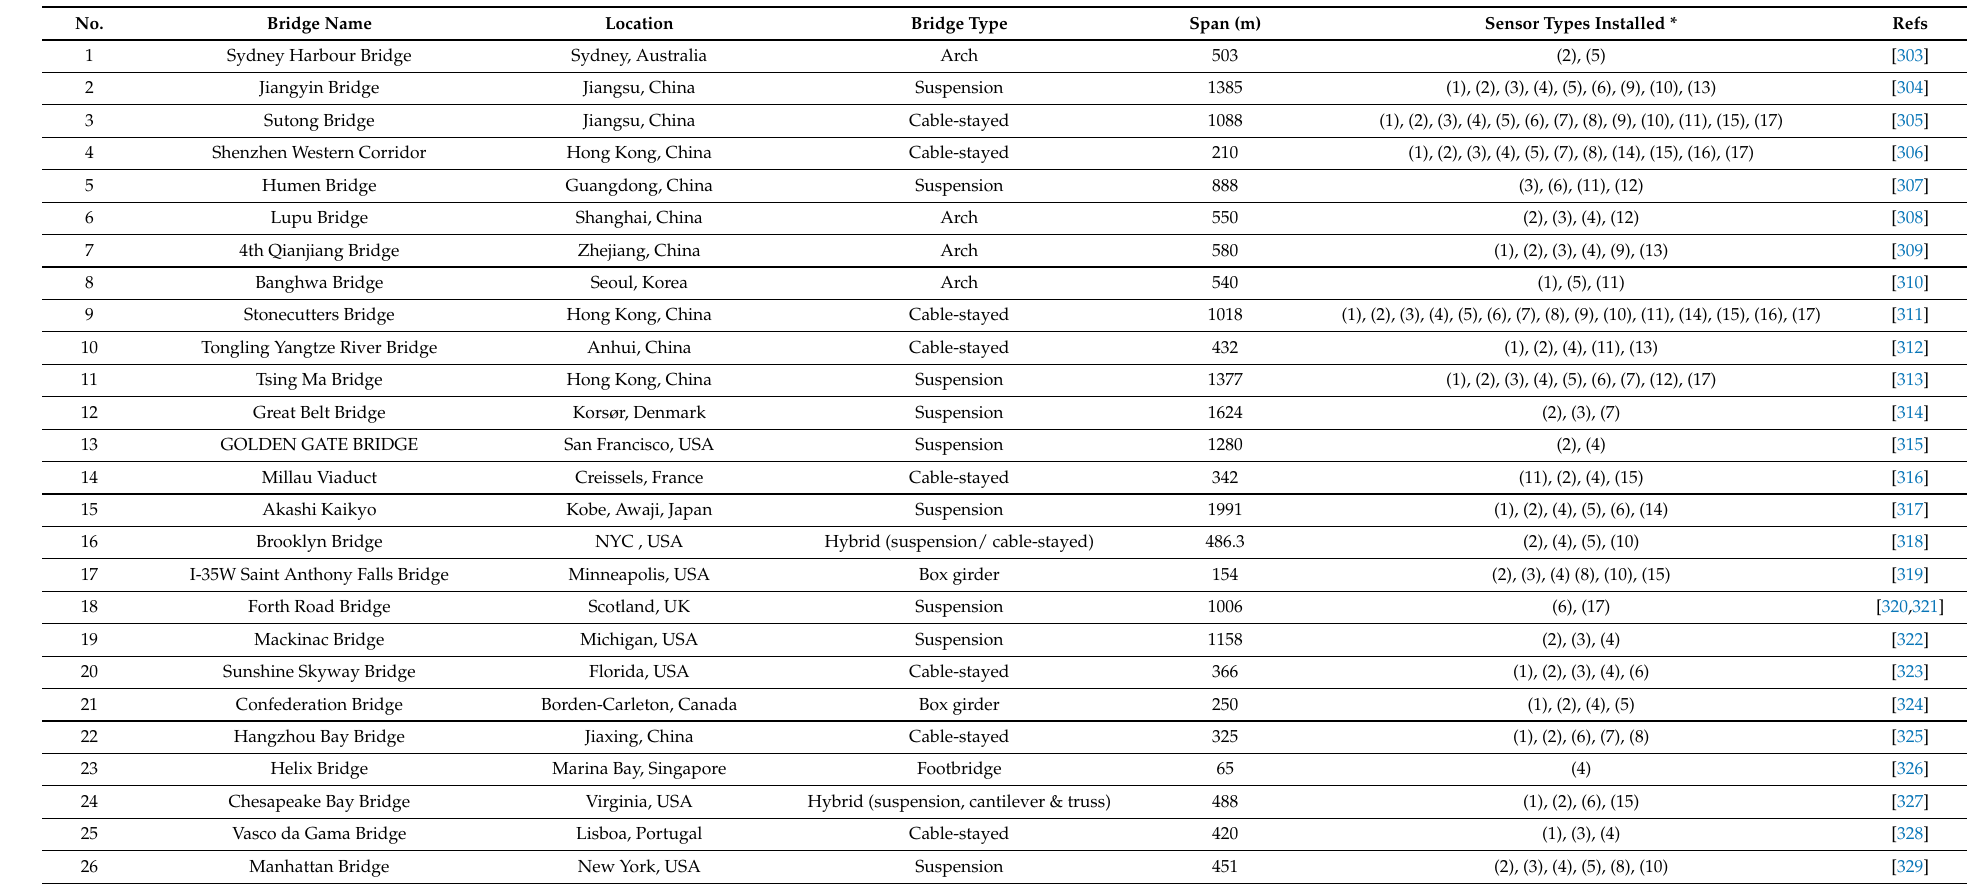
Table 14. Main bridges in the world equipped with SHM